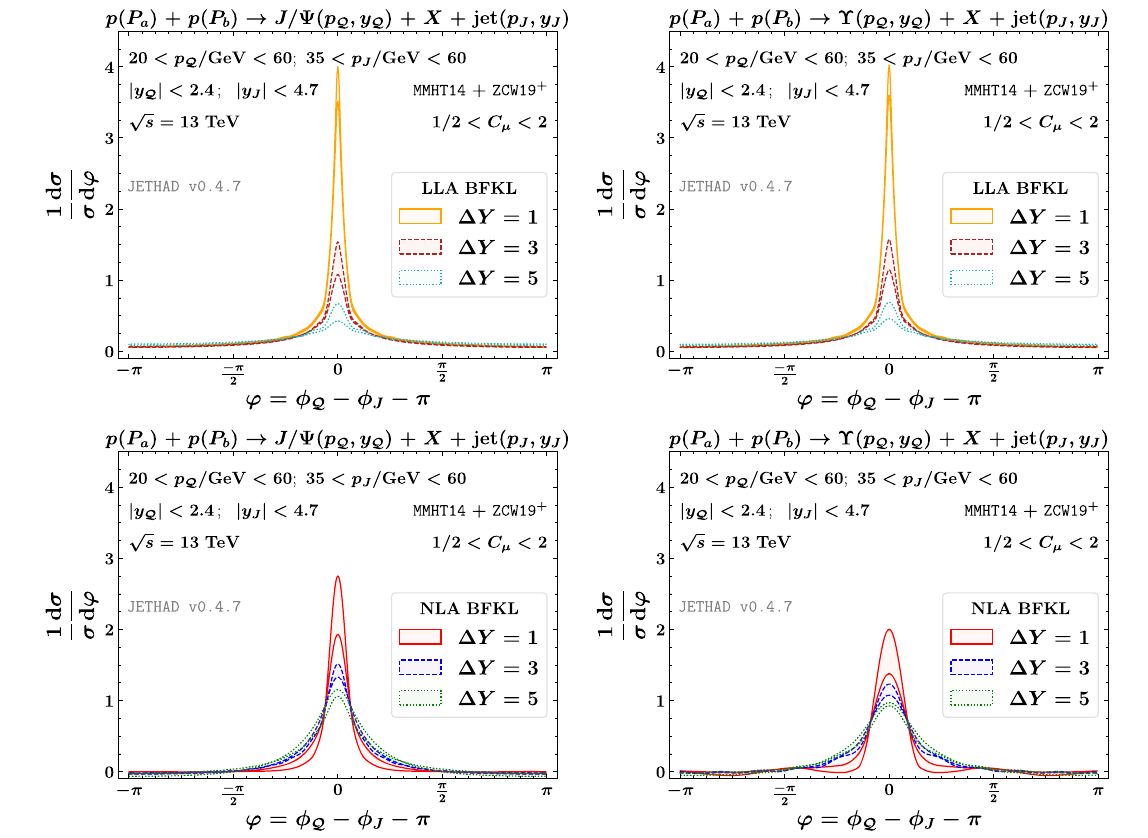
Fig. 7 LLA (upper panels) and NLA (lower panels) predictions for the ϕ -distribution in the J /ψ + jet (left) and in the ϒ + jet (right) channel, √ s = 13 TeV, and for three distinct values of (cid:9) Y . Quarkonium frag- at mentationisdescribedintermsof ZCW19 + functions.Textboxesinside